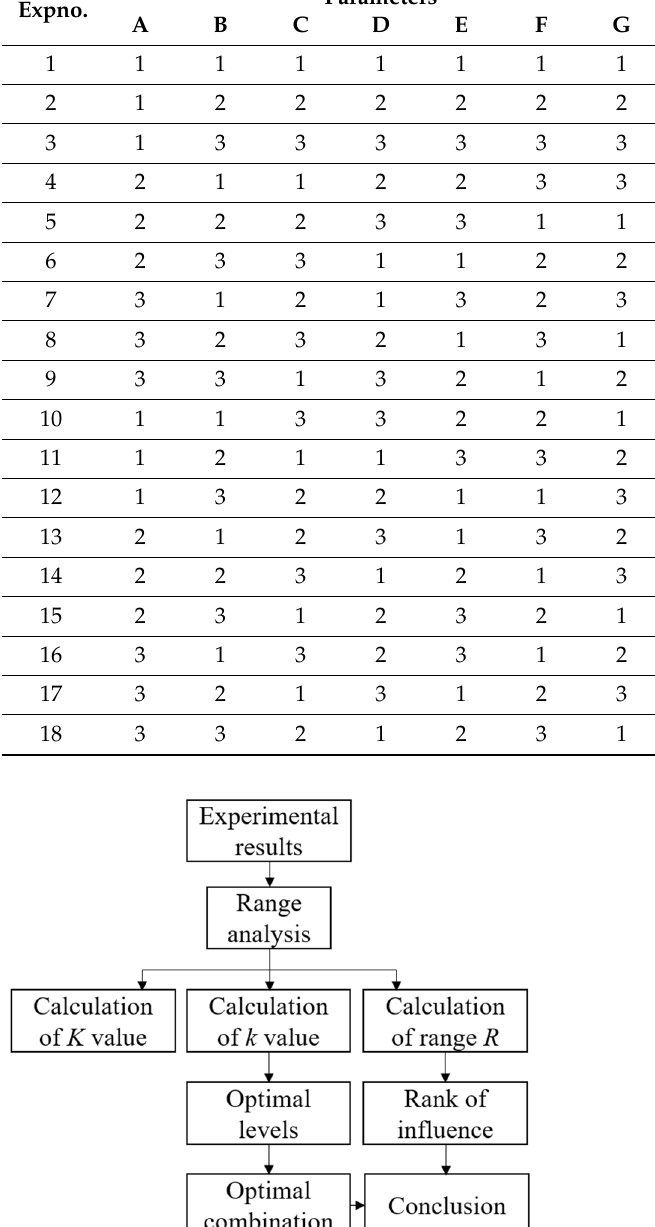
tion speed of workpiece and polishing tool and external load. In contrast, surface rough- ness increased with the increase in abrasive particle size. Smaller abrasive particle size can obtain a larger amount of particles, which result in a larger contact interface between abra- sive particle and the workpiece surface and enhance solid-phase reaction intensively. In this case, material can be removed efficiently and smoother surface can be attained easily. Thus, it can be seen that the 200 nm in size achieves the smallest surface roughness com- pared with other sizes. The higher sand bond ratio means larger number of abrasive par- ticles; more peak-valleys on the surface can be removed during the processing, which de- creases the surface roughness in high efficiency. The sand bond ratio 5:1 performs best in smoothing the surface. The revolution speed of workpiece and polishing tool affects sur- face roughness less than other parameters. External load has the greatest effect on surface roughness: the greater the external load, the better the surface quality. Figure 7. Relationship between parameters and surface roughness R a. The relationship between parameters and the material removal rate is shown in Fig- ure 8. When 5 μ m in abrasive particle size was employed for polishing, the average pol- ishing force acted on each particle was larger than with a smaller size because the number of abrasive particles with 5 μ m diameter was much fewer than with others. Thus, the ma- terial removal depth induced by cutting edge of abrasive particles is higher during pol- ishing. However, larger abrasive particle size may cause overlarge polishing force on the